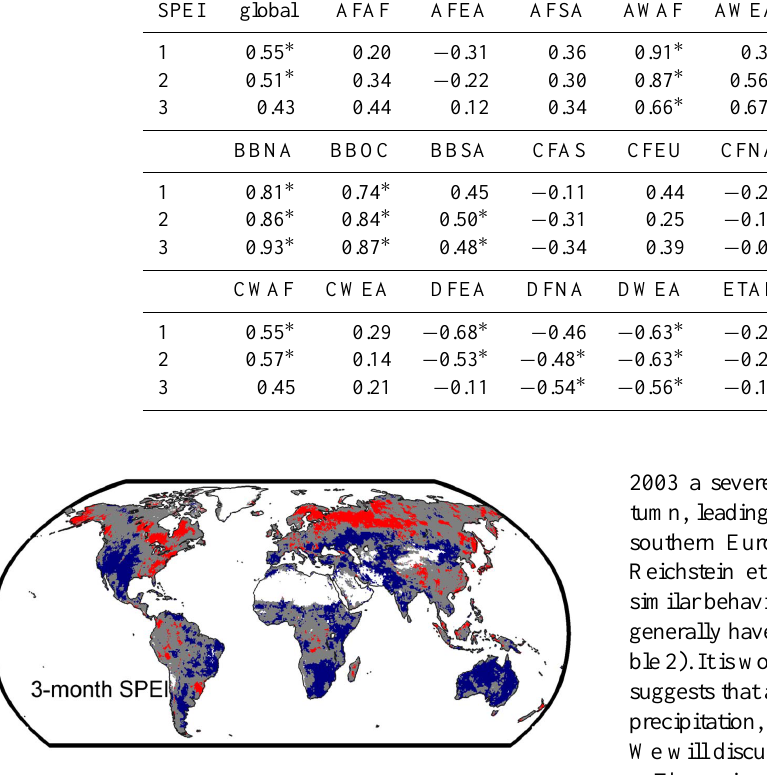
Figure 3. Spatial distribution of Pearson’s correlation coefficients between annual anomalies of NPP and SPEI (3-months). Correlations that are significant (p<0.1) are displayed in blue (positive) and red (negative). Grey areas indicate correlations that are not significant and white areas are not available due to data structure.